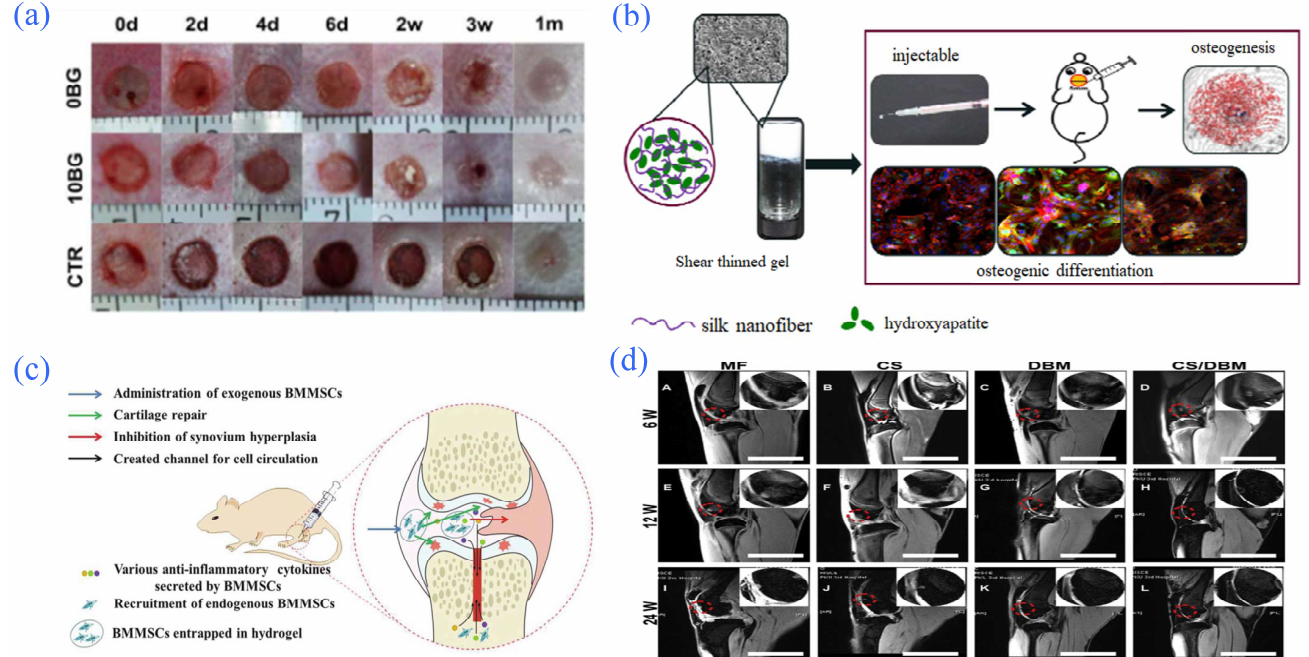
Figure 8. Application of hydrogel in partial tissue engineering. ( a ) Process of wound healing promoted by the hydrogel. Reprinted with permission from Ref. [125]. Copyright 2015, Zeng, Q. ( b ) Involvement of hydrogels in repairing bone defects. Reprinted with permission from Ref. [128]. Copyright 2017, Ding, Z. ( c ) Schematic diagram of the possible mechanism of hydrogels loaded with bone marrow mesenchymal stem cells in alleviating collagen-induced arthritis. Reprinted with permission from Ref. [135]. Copyright 2015, Liu, H. ( d ) Specimen of rabbit cartilage after allogeneic chondrocyte transplantation and repair of demineralized bone matrix composite scaffold using chitosan hydrogel. Reprinted with permission from Ref. [139]. Copyright 2016, Man, Z.